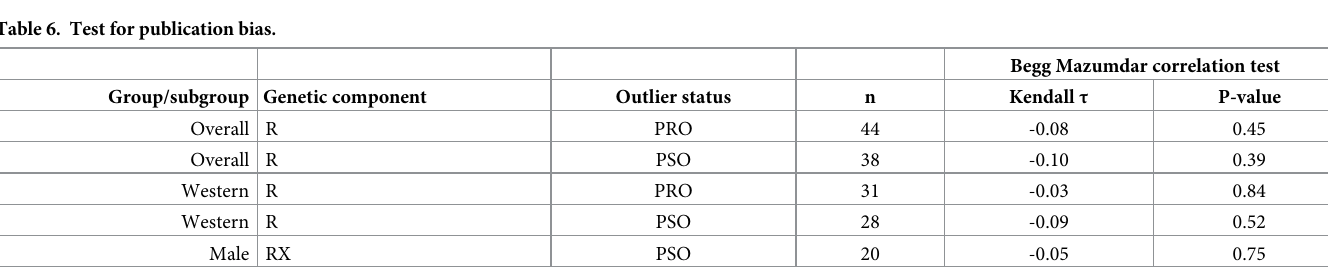
Table 6. Test for publication bias. Group/subgroup Genetic